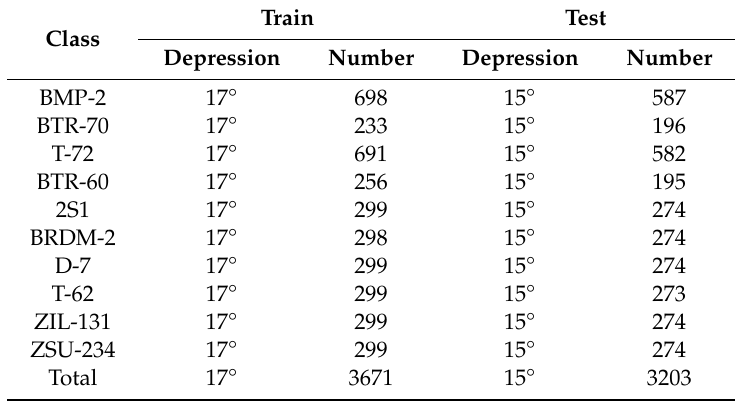
Table 1. Training and test samples for the standard operating conditions (SOC) experiments setup.